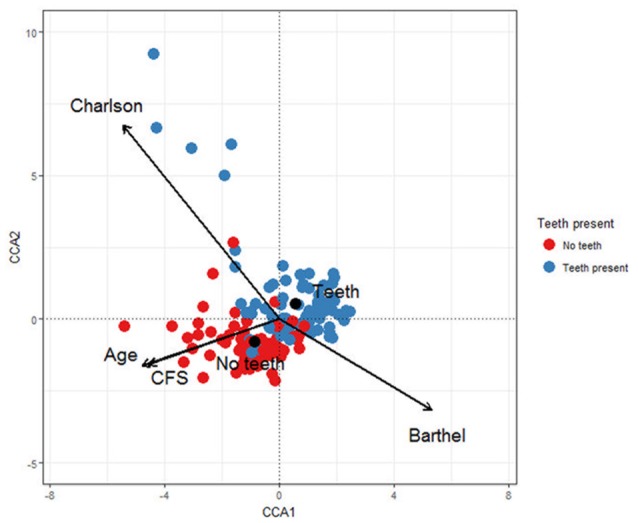
Canonical correspondence analysis showing the relationships between the microbial communities in hip fracture patients' mouths and Charlson score, Age, Clinical Frailty Score (CFS), Barthel score and whether teeth are present or absent.